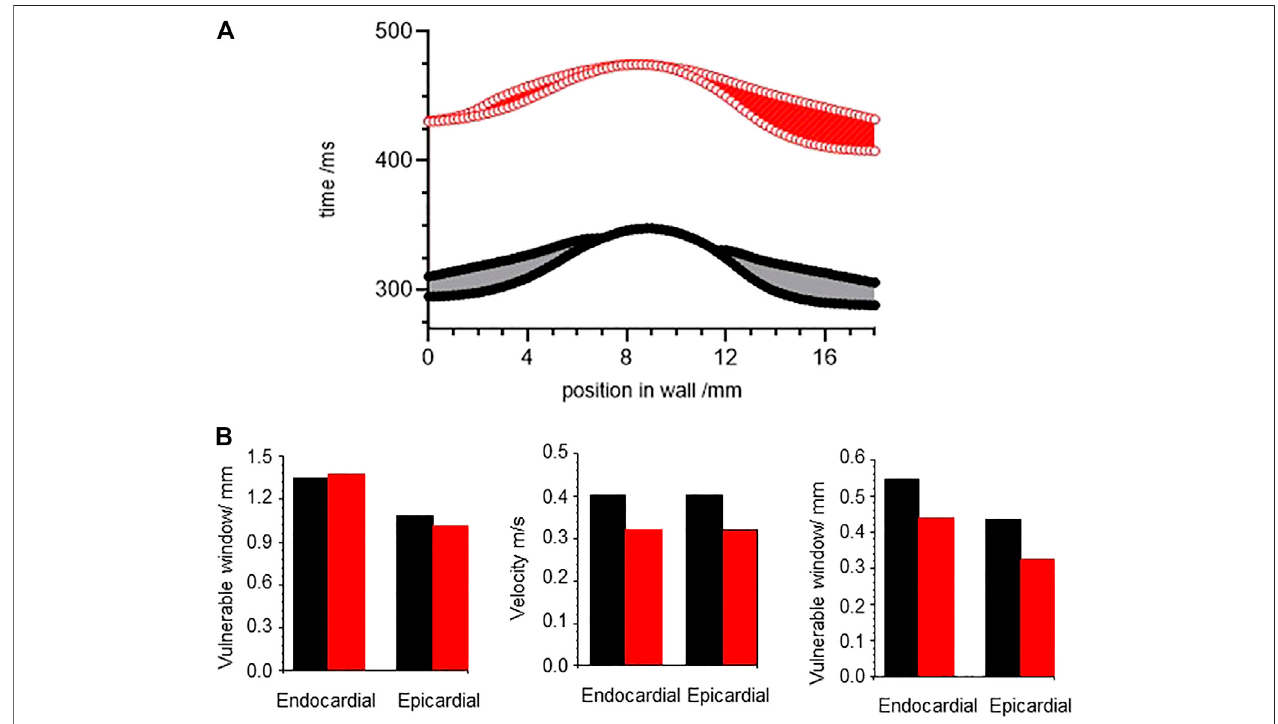
FIGURE 10 | CO differentially changes vulnerable window. (A) temporal vulnerable window computed for an 18 mm one-dimensional ventricular wall ORd model, withequal thirdsofendocardial,midmyocardial and epicardial tissue. (B) conduction velocity,wavelength, temporal and spatial vulnerable windows for onedimensional ORd models of homogeneous ventricular epicardial and endocardial tissues. Strand was paced at a BCL (cid:1) 1000 ms to establish the initial resting conditions, and VW determined at each space step.